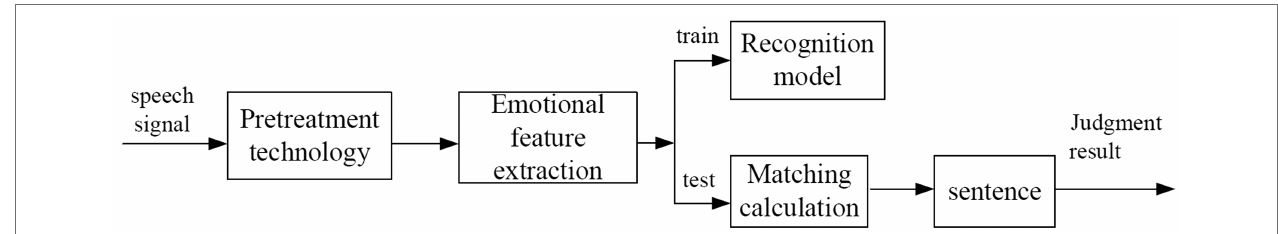
FIGURE 1 | Block diagram of speech emotion recognition